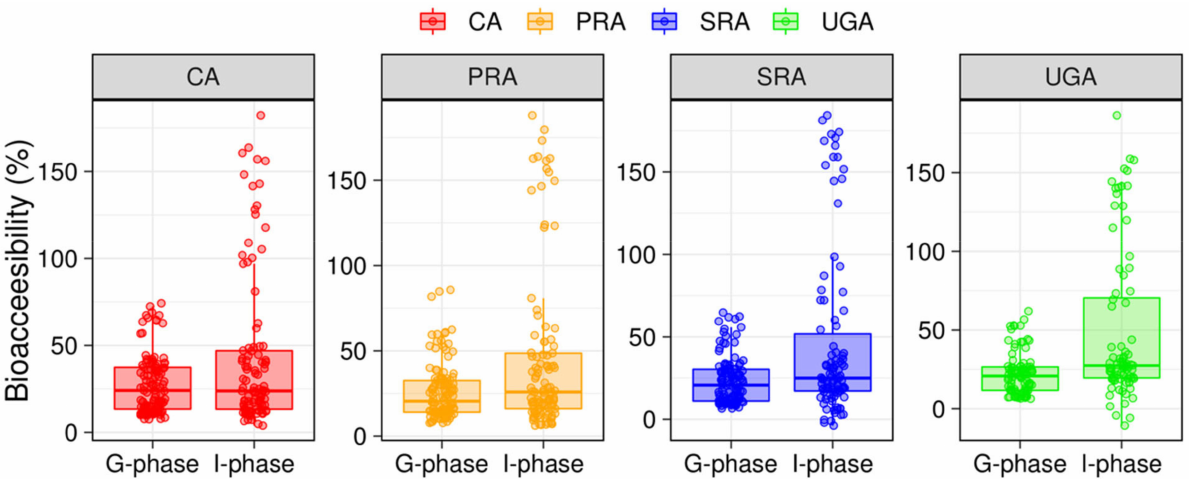
Figure 4. Bioaccessibility of gastric (GP) and intestinal (IP) phases in different land-use areas. CA = commercial area, PRA = planned residential area, SRA = spontaneous residential area, UGA = urban green